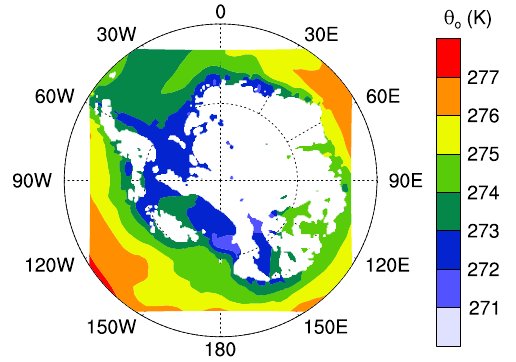
Figure 3. Ocean potential temperature at 300m depth, as given by ECHAM53 (Braconnot et al., 2007). In the areas where no water is present, a mask has been placed (transparent areas in the